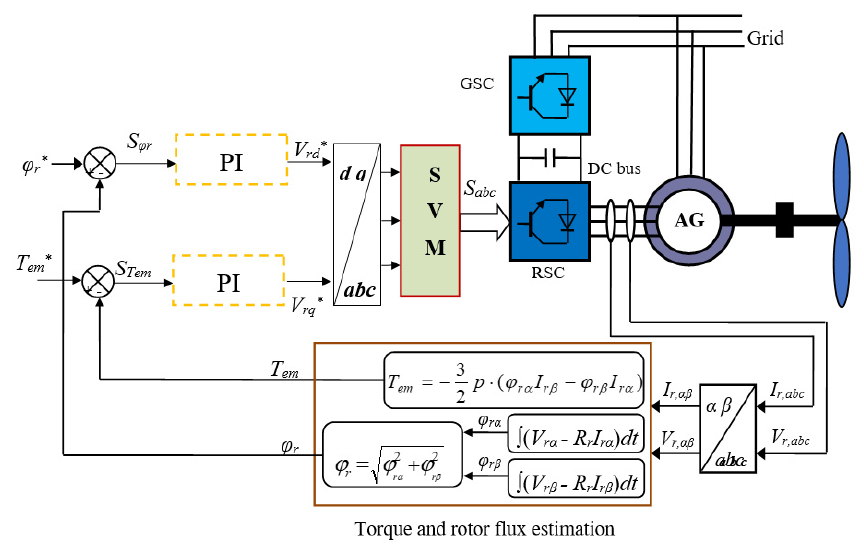
Figure 1. Structure of the DFTC strategy with PI controllers.